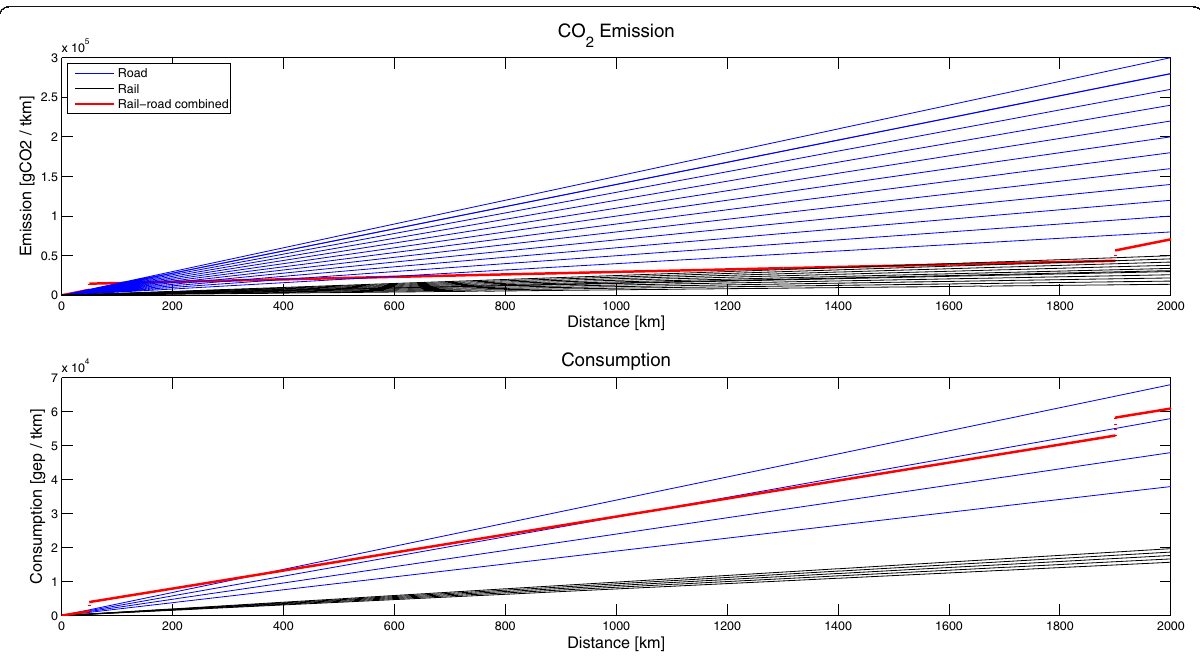
Fig. 4 Example of CO2 and consumption for combined rail-road